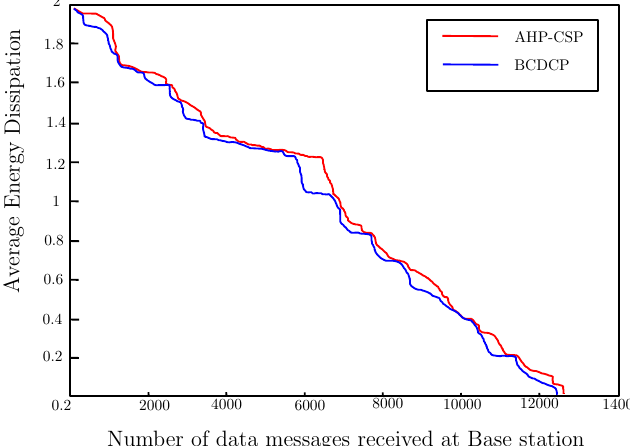
Figure 7. The total number of data messages received at the base station as a function of average energy